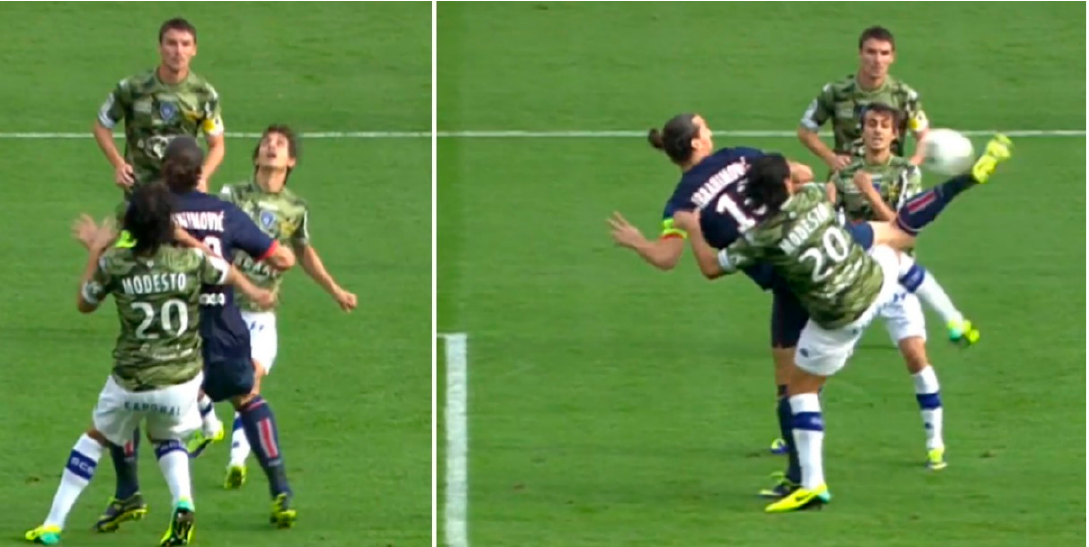
Figure 5. The scorpion kick, a nominated goal of FIFA Puskás Award 2014 performed by Ibrahimovi ć (the figure was generated from the video of FIFA Puskás Award 2014).